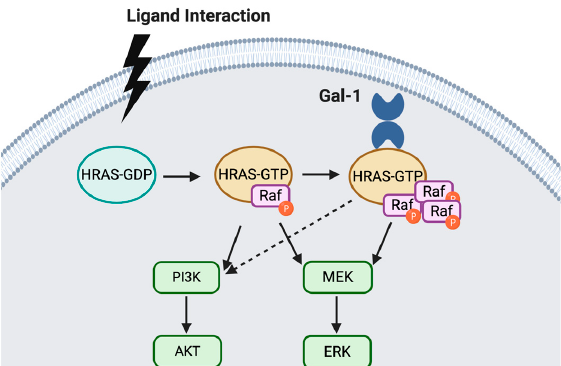
Figure 2. Oncogenic H-Ras plays a major role in tumor transformation via two major pathways, PI3K/AKT and MEK/ERK [73,74]. H-Ras recruits intracellular Gal-1 from the cytosol. This interaction